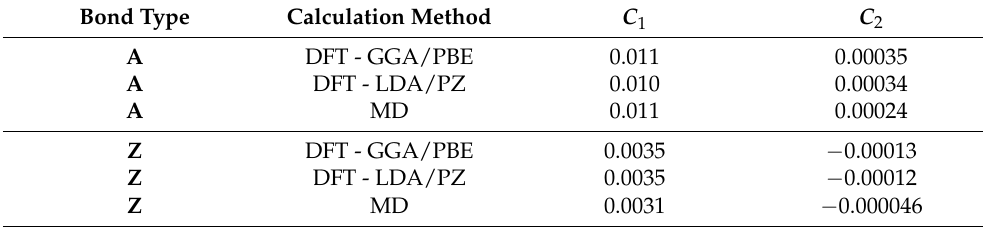
Table 1. Coefficients C 1 [in Å/(%strain)] and C 2 [in Å/(%strain) 2 ] of the strain dependence of the lengths [see Equation (1)] for the bond types A and Z, when the strain is applied along the armchair direction, as obtained by the results of the different theoretical methods used in this work.